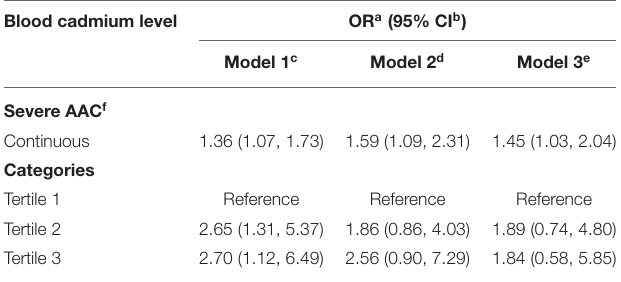
TABLE 3 | Multivariate logistic regression models of the AAC group with blood cadmium levels (severe AAC vs. no AAC).